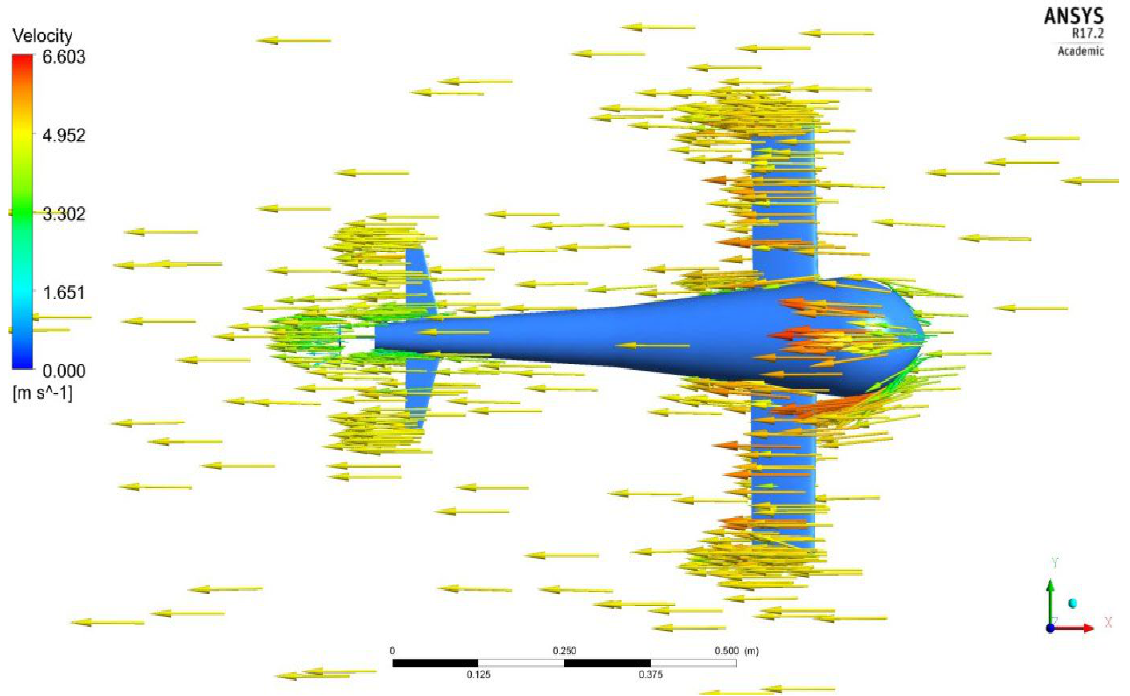
Figure 34. Hydrodynamic velocity generation over the optimised UAV.